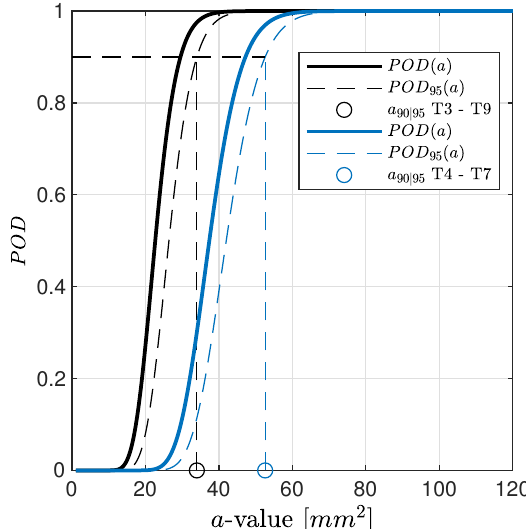
Figure 10. POD versus flaw size related to damage D1 and paths T3–T9 and T4–T7. Regression model used to estimate ˆ a is according to Figure